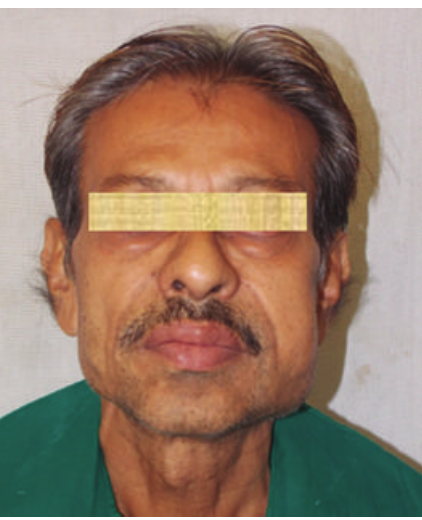
Figure 1: Preoperative picture showing an extraoral swelling at the left angle and ramus region of the mandible.